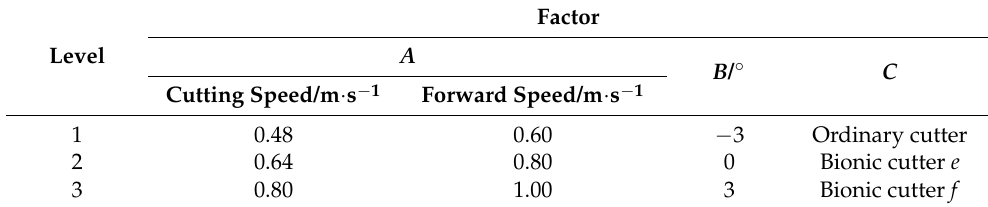
Table 5. Factors and levels of orthogonal experiment.